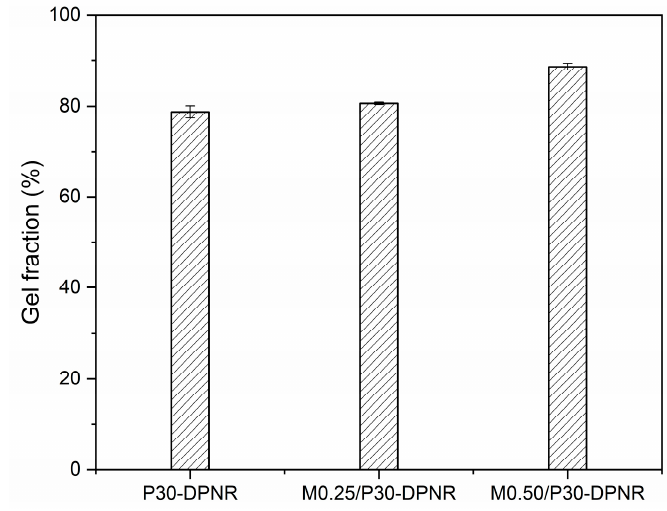
Figure 3. Gel fraction of P30-DPNR, M0.25/P30-DPNR and M0.50/P30-DPNR.